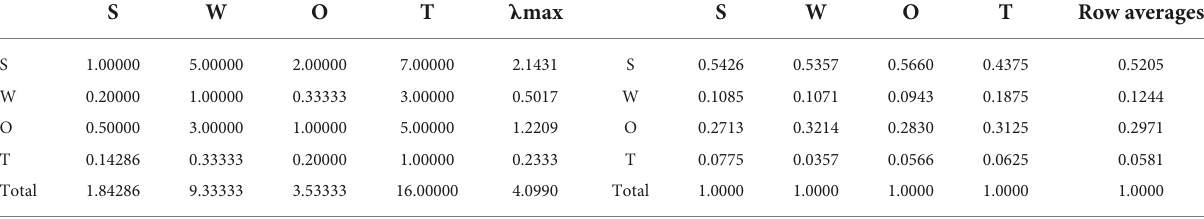
TABLE 3 AHP factors and descriptions in SWOT-Matrix (weight of SWOT